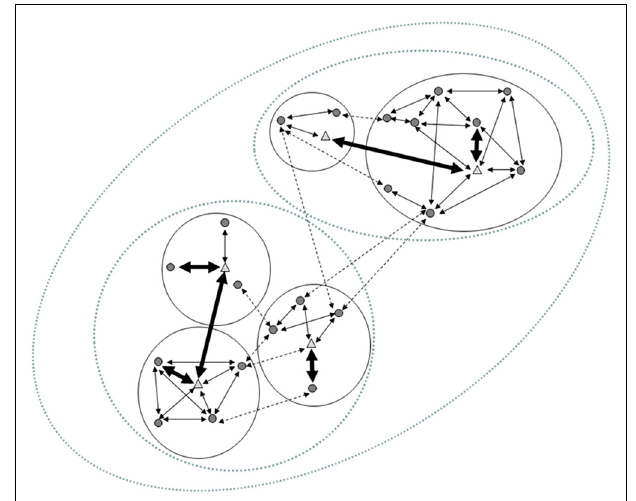
FIGURE 2 |The typical structure of the multi-layered Hamadryas baboon society. The smaller social unit (a “one-male-unit”, OMU) in the Hamadryas society is that formed by an adult male ( triangles ), adult females ( circles ) and their offspring. In these units social relationships tend to be circumscribed to members of the same unit (expressed here by arrows, representing social relationships -within bold circles).These units are often formed when larger OMUs fission or when young bachelors sequester peripheral (usually young) females from a large OMU; retaining them in close proximity by force and aggression. Adult females in the same OMU are seldom kin.This produces that strong social relationships ( bold arrows ) are usually established between a female and her unit’s male, not among females in the same OMU.While both sexes can have relatives in other OMUs, social contacts among females from different units are less common ( dotted arrows ), whereas adult males may in fact establish strong alliances with males from other units (which may actually be their kin) forming “clans” ( bold arrows across different OMUs). Spatial association between individuals of different OMUs (e.g., foraging in relative proximity) can result in the third level of the Hamadryas society: a “band” ( medium-sized dotted ovals ). Finally, different bands congregate in the same cliffs to sleep, forming the largest identifiable group: the “troop” ( largest dotted oval